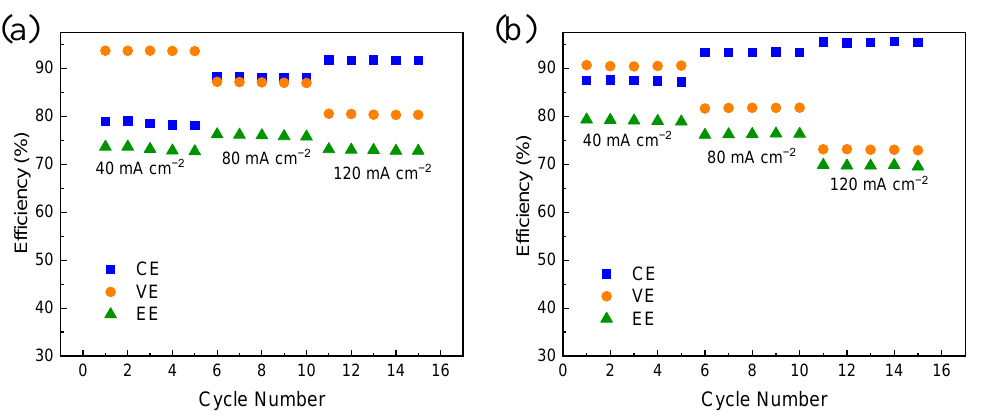
Figure 5. The performance of VFBs with ( a ) M2-300 ( b ) M3-300 membrane at the different current densities.